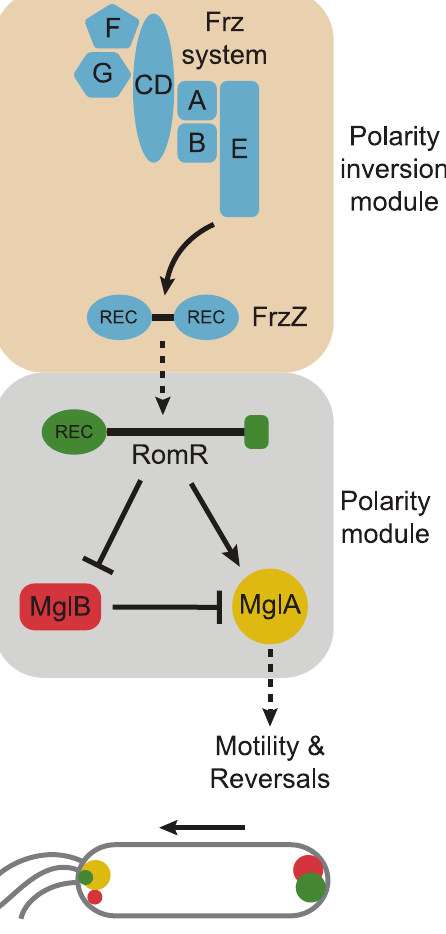
Figure 6. Model for dynamic cell polarity regulation in M. xanthus . The upper schematic illustrates the interactions between the Frz chemosensory module for polarity inversion (light brown back- ground) and the MglA/MglB/RomR polarity module (light grey background). Arrows and T-bars indicate direct interactions and the stippled arrow that the molecular mechanism underlying this interaction is not known. The lower schematic illustrates the localization of the MglA, MglB and RomR proteins in a cell moving in the direction indicated by the arrow and with T4P at the leading pole. The color code is as in the upper